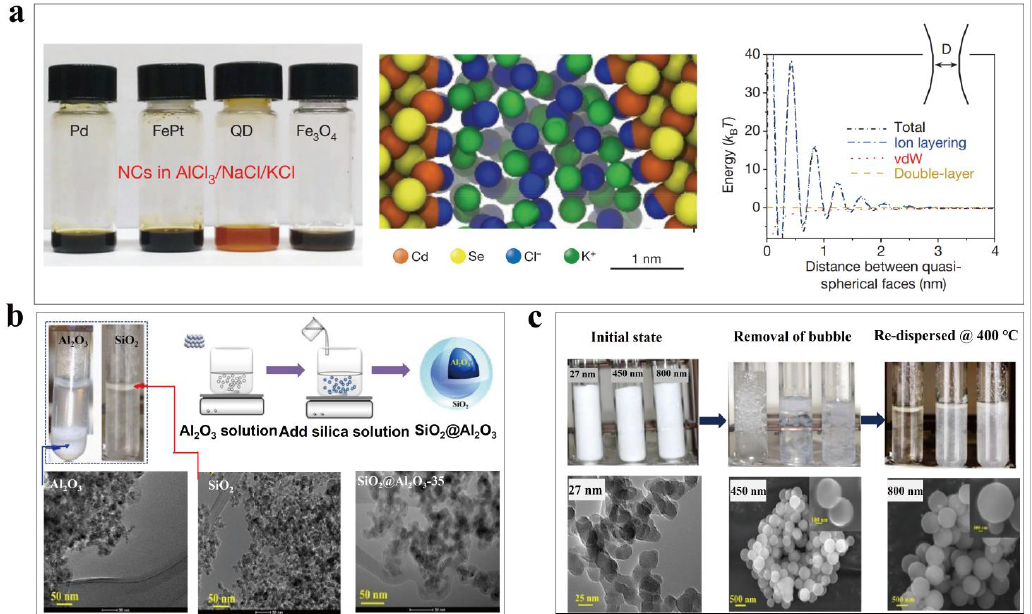
Figure 7. ( a ) Homogeneous dispersion of colloidal nanoparticles within molten salts due to chemical affinity between the nanoparticle surfaces and the molten salt ions (( a ) reprinted/adapted with per- mission from Ref. [115]. 2017, Springer Nature). ( b ) Core-shell SiO 2 @Al 2 O 3 nanoparticles dispersed within melted solar salts due to reduced sedimentation tendency through matching the density of particles and molten salts. (( b ) reprinted/adapted with permission from Ref. [119]. 2019, Elsevier). ( c ) Dependence of nanofluid dispersion stability on the size of SiO 2 particles (( c ) reprinted/adapted with permission from Ref. [120]. 2022, Elsevier).